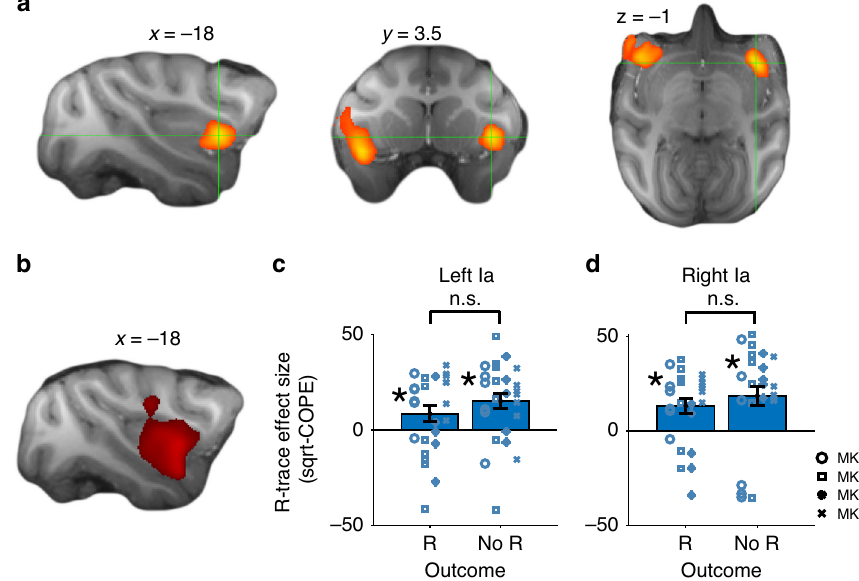
Fig. 6 Bilateral Ia represents global reward state and current reward. a Positive effects of R-trace bilaterally in Ia. b Both regions also showed concurrent overlapping or closely adjacent positive activation related to the current outcome (reward – no reward). c , d In accordance with our RL model, in both regions, R-trace exerted a positive effect during rewarded as well as unrewarded trials. These effects were revealed by two-sided one-sample t -tests against zero ( p -values for left Ia are: p (R) = 0.049, p (no R) = 0.01; p -values for right Ia are: p (R) = 0.002, p (no R) = 0.001) and two-sided paired t -tests (difference in left Ia: p = 0.23 and right Ia: p = 0.47). ROIs were selected using a leave-one-out procedure. (Crosshairs highlight peak coordinates for subsequent ROI analysis; data are presented as mean values ±SEM across sessions; n = 25; dot color in c , d indicate monkey identity; all MRI results cluster-corrected at Z > 2.6, p = 0.05; asterisks indicate p < 0.05; n.s. indicates not signi fi cant). Source data are provided as Source Data fi le. Symbols indicate monkey identity in panels c , d ; MK abbreviates